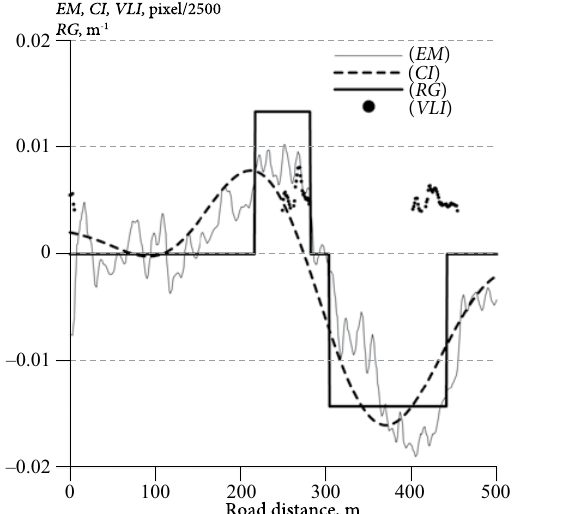
Fig. 6. Relationship between CI function of the sample and EM and VLI for a specific driver (the ordinates in pixel of EM , CI and VLI were scaled for 2500 to represent also the curvature diagram ( RG ) in the same graphic; the data concern the road distance from 0 to 500 m)